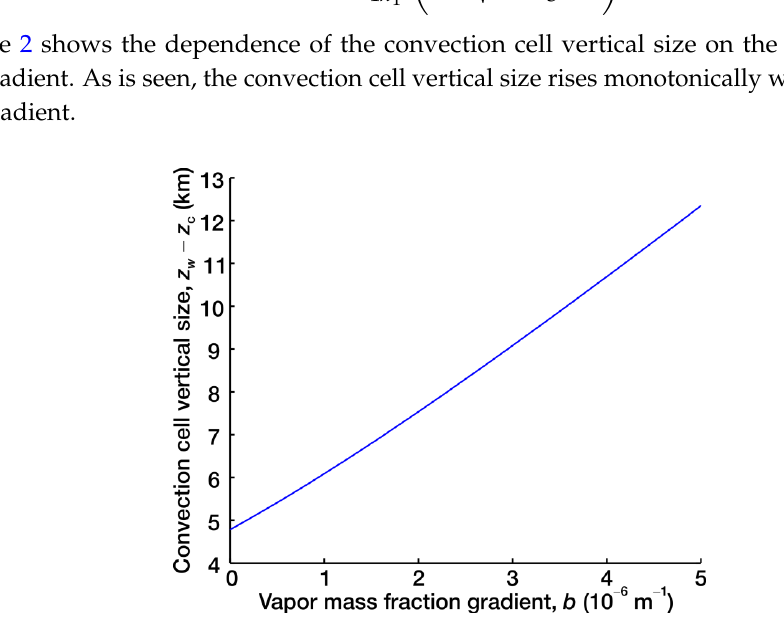
Figure 2. Convection cell vertical size vs. water vapor mass fraction gradient. The atmospheric parameters are the same as in Figure 1.